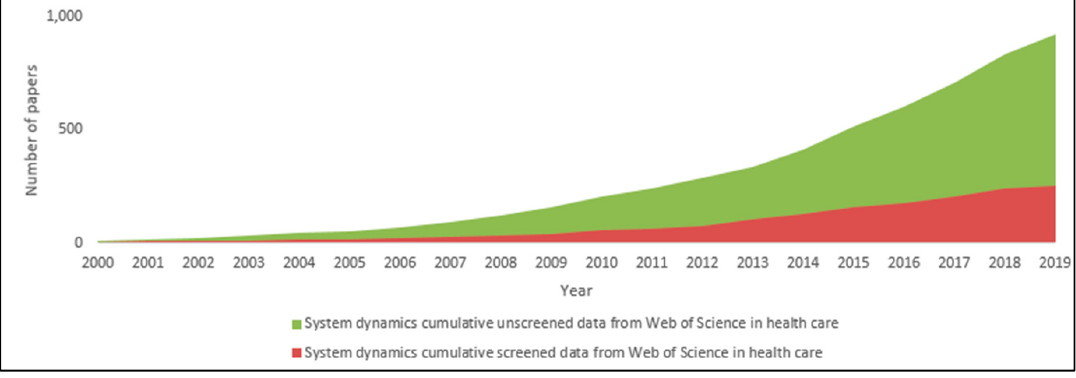
Figure 3. Published papers before and after the screening process.